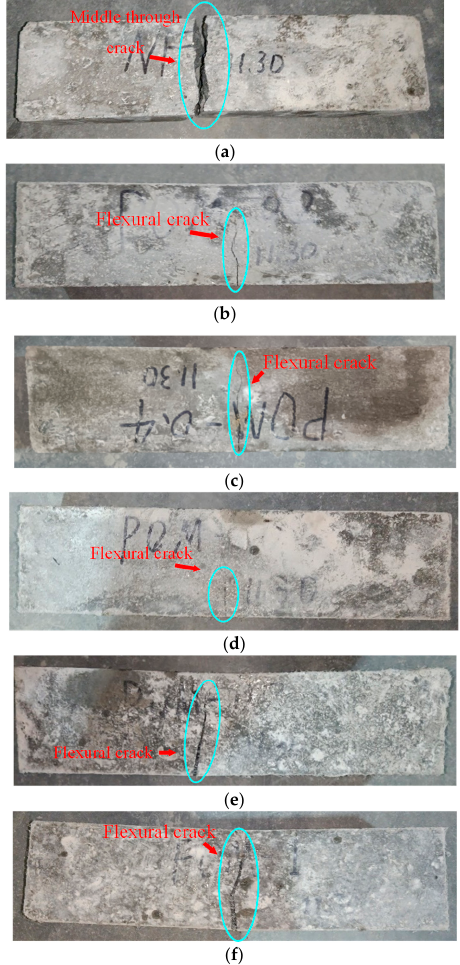
Figure 24. Failure performance of flexural tests: ( a ) NF; ( b ) POM-0.2; ( c ) POM-0.4; ( d ) POM-0.6; ( e ) POM-0.8; ( f ) POM-1. Table 11. Results of flexural tests of SWSSC with different mixes.